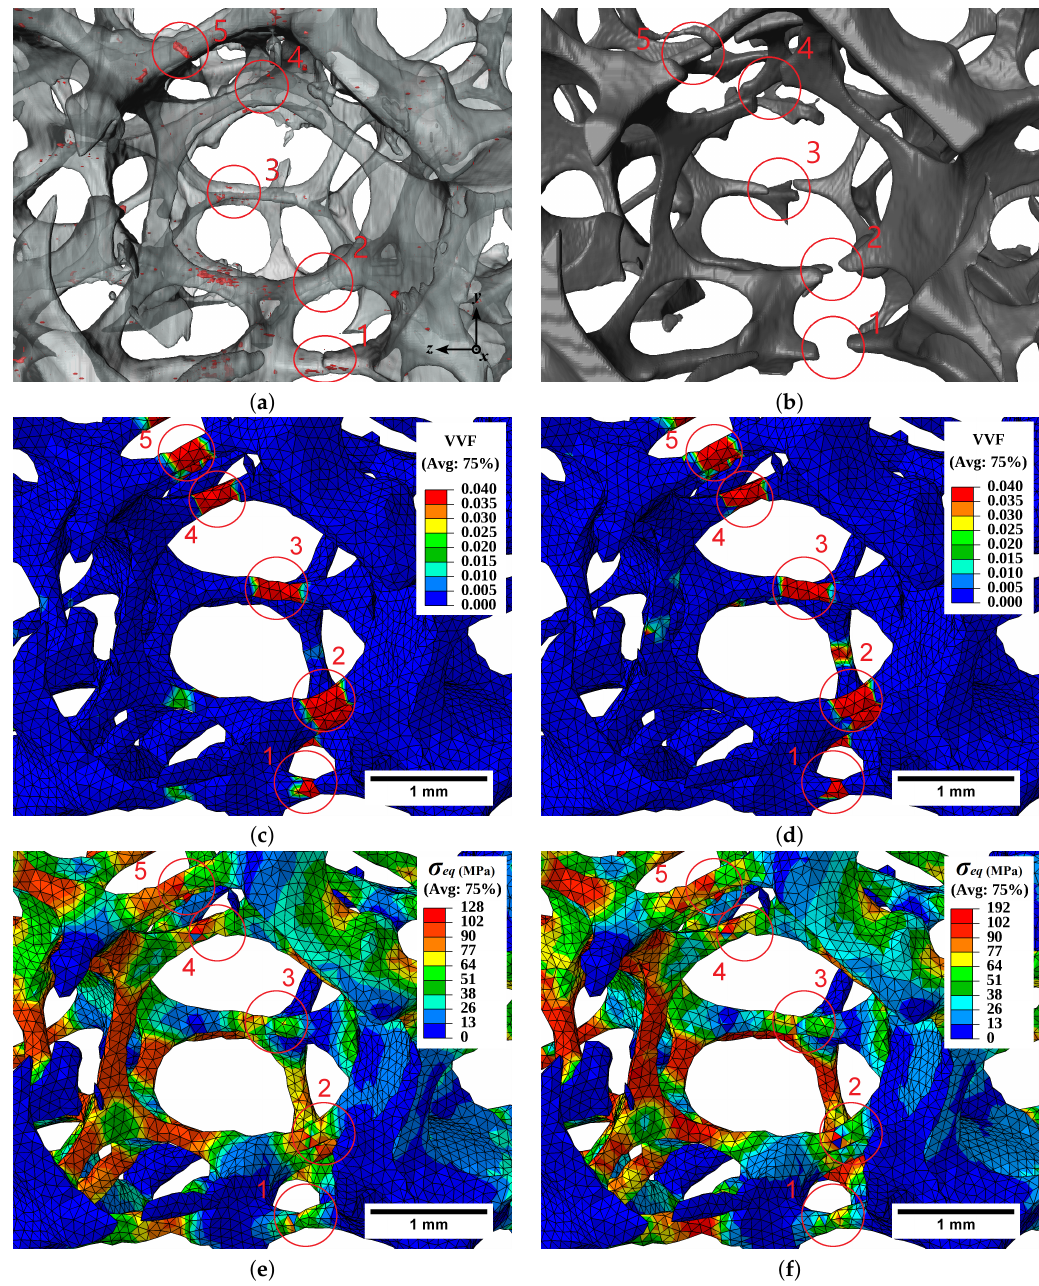
Figure 12. ( a ) Distribution of intermetallic particles in the solid phase of the 20 PPI sample. ( b ) Fractured struts of the foam. FE contour plots (at 6.4% strain) of VVF with the ( c ) homogeneous and ( d ) heterogeneous GTN models. Corresponding contour plots of equivalent stress with the ( e ) homogeneous and ( f ) heterogeneous GTN models. Struts of interest are labeled 1 to